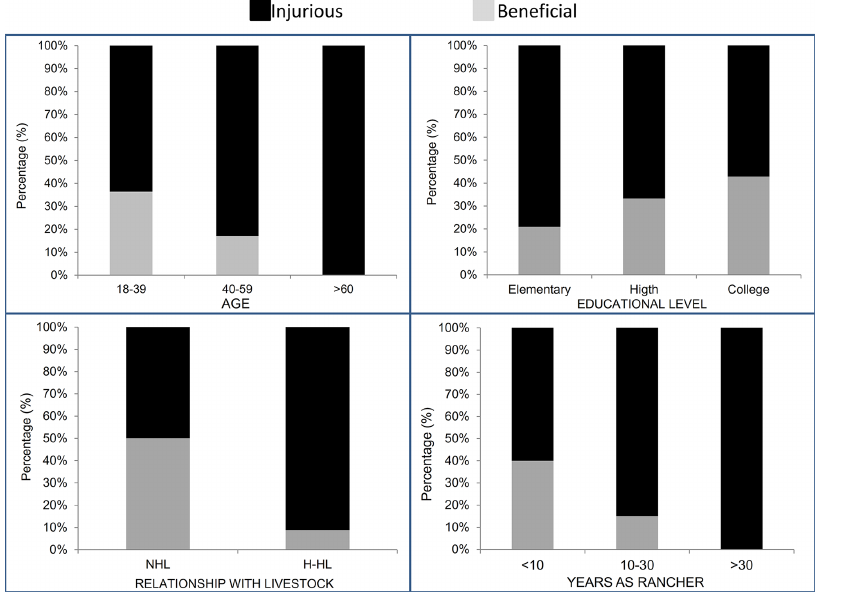
Fig 1. Perception of respondents (%) toward Andean condors split by social factors. A) Age, B) Education level, C) Livestock ranching (NHL, never had livestock; H-HL, have or had livestock) and D)